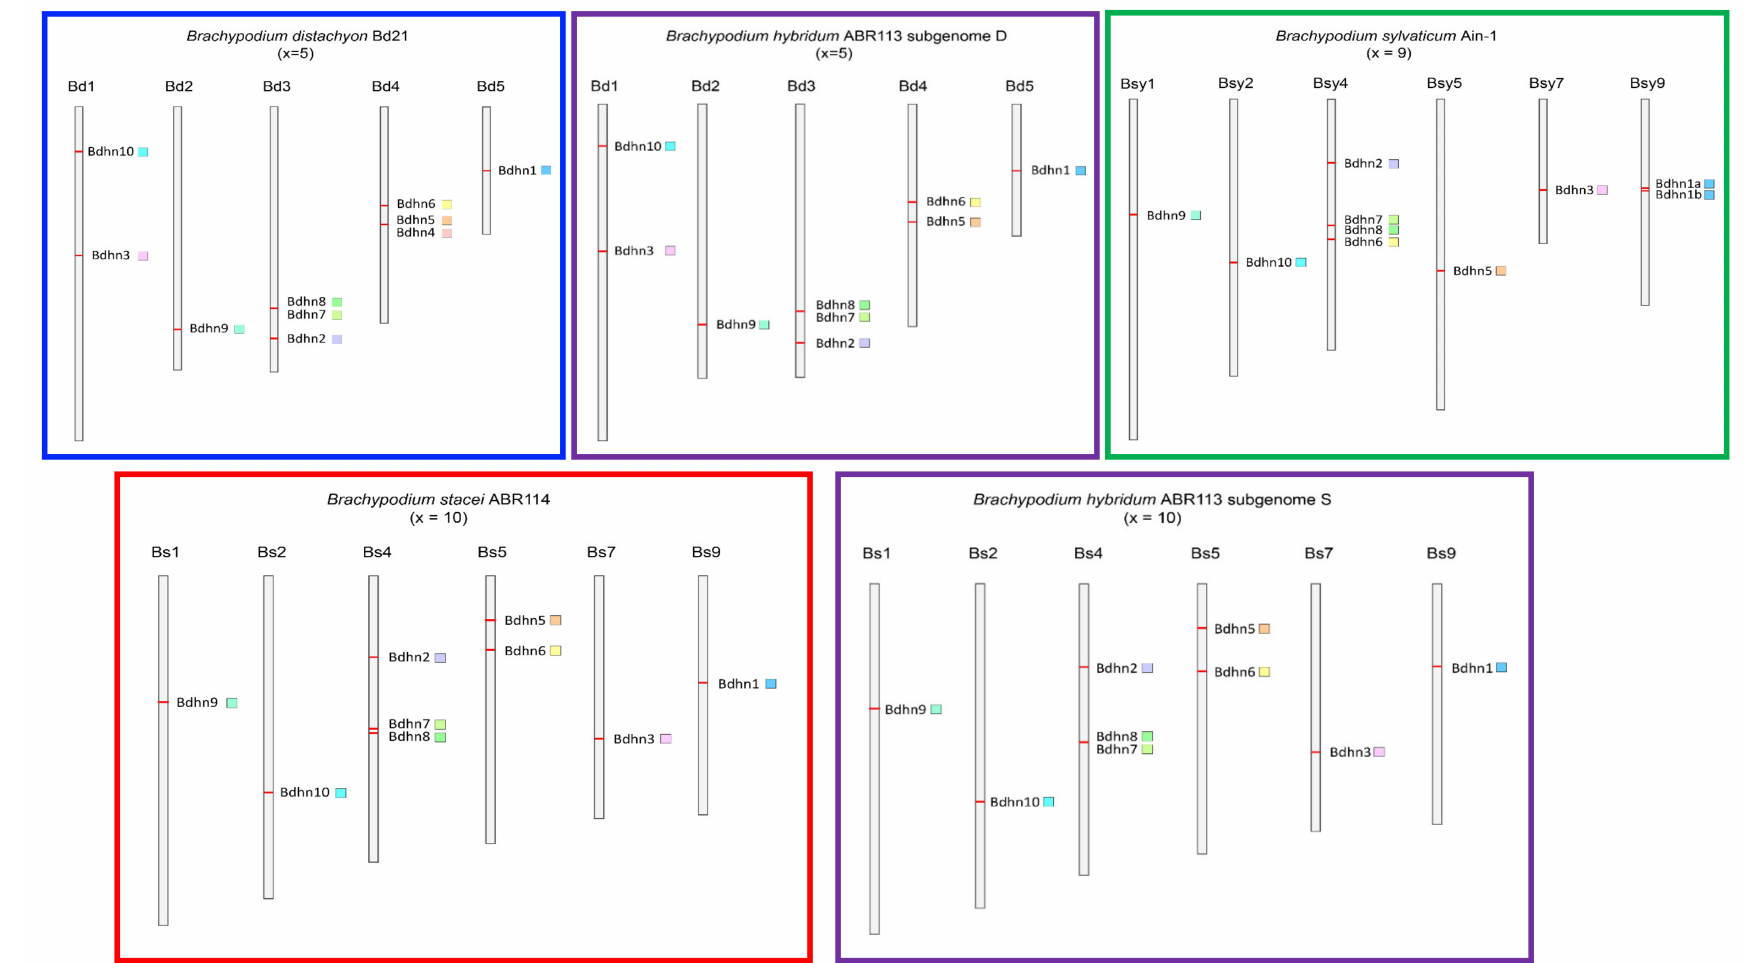
Figure 3. Chromosomal location of Bdhn genes in the studied Brachypodium species. B. distachyon (blue rectangle), B. stacei (red) , B. hybridum subgenomes S and D (purple), and B. sylvaticum (green). Bdhn genes are mapped on the chromosome with their respective color flags (see Figure